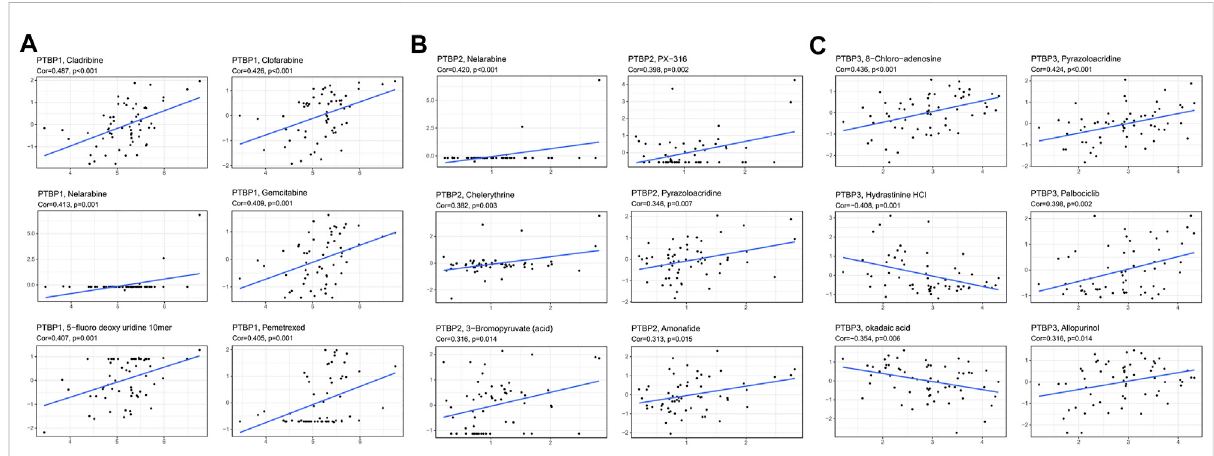
FIGURE 8 Pearson correlation of PTBP expression with drug sensitivity scores in various tumor cell lines in Cellminer. The top six drugs with the largest absolute value of the correlation coef fi cient are displayed. (A) Correlation of PTBP1 with drug sensitivity. (B) Correlation of PTBP2 with drug sensitivity. (C) Correlation of PTBP3 with drug sensitivity. The correlation coef fi cient and p value are marked in the fi gure.